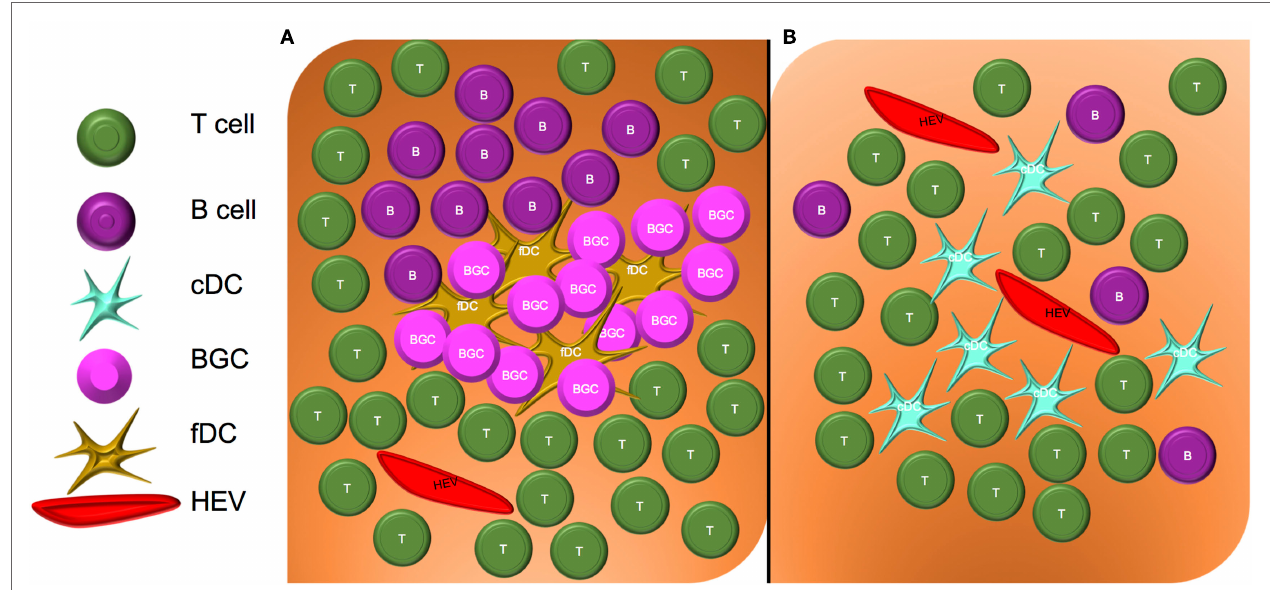
FiGURe 2 | Structure of classical and non-classical tertiary lymphoid organs . (A) Classical TLO contain a nucleated core of fDC and germinal center B cells (BGC), surrounded by an HEV-containing T cell zone. (B) Non-classical TLO do not contain fDC or BGC, but may contain sparse B cell, T cell, and DC infiltrates surrounding